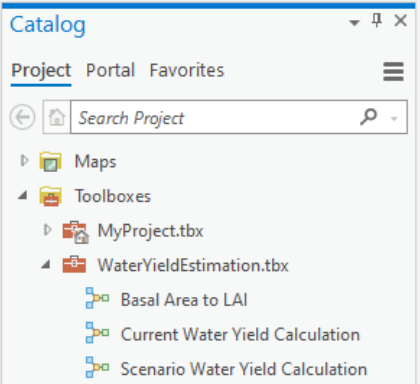
Figure A2. Adding the Water Yield Estimation toolbox to the project toolboxes folder.